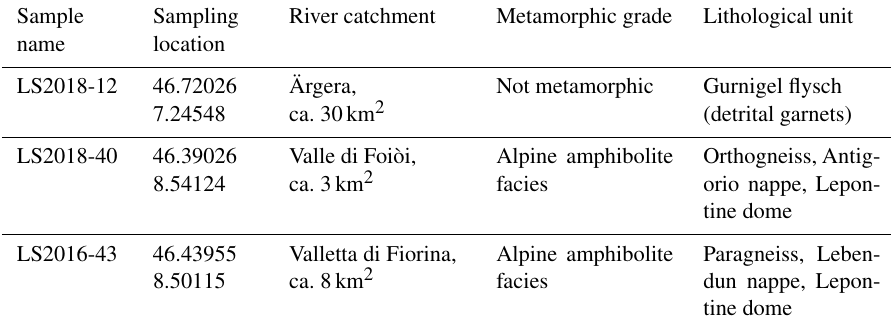
Table 2. Sample locations and characteristics of potential sources (tributary sampling